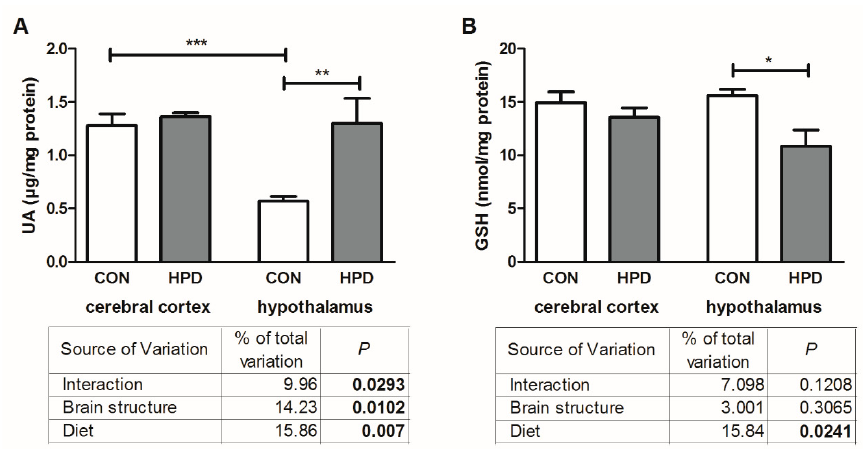
Figure 2. Effect of 8-week HPD on non-enzymatic antioxidants (uric acid ( A ), reduced glutathione ( B )) in rat cerebral cortex and hypothalamus. Values are means ± SEMs, n = 9. Differences statistically significant at: * p < 0.05, ** p < 0.005, *** p < 0.0005. CON, standard diet; GSH, reduced glutathione; HPD, high protein diet; UA, uric acid.